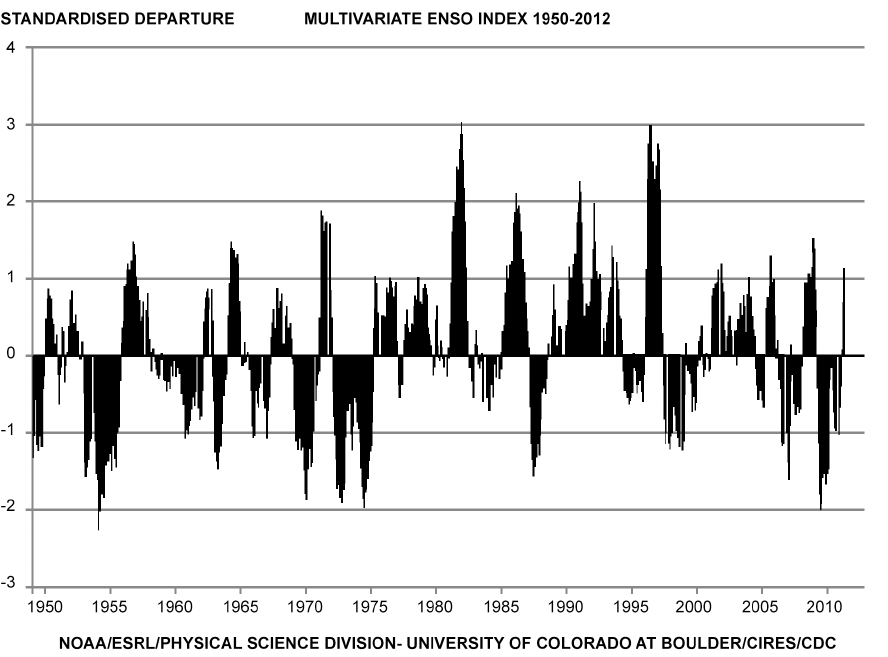
Figure 4. Multivariate ENSO index (MEI) data 1950 to 2010 (Wolter and Timlin 2011 and NOAA). Data sourced from www.noaa.com.